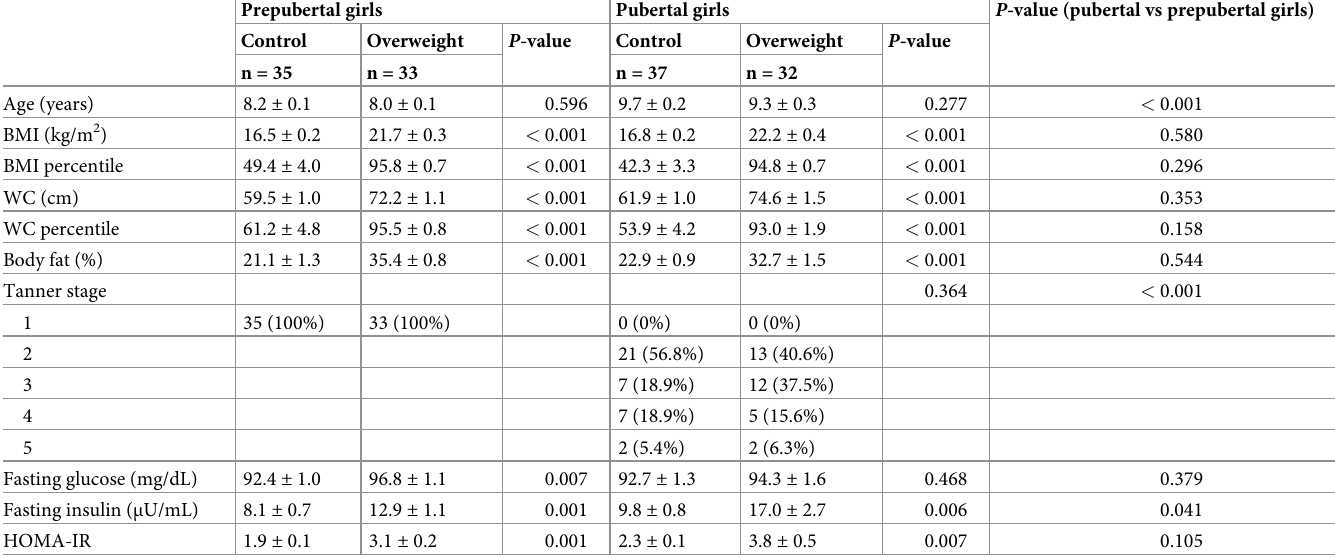
Table 1. General characteristics of the study subjects by obesity and the puberty status. Prepubertal